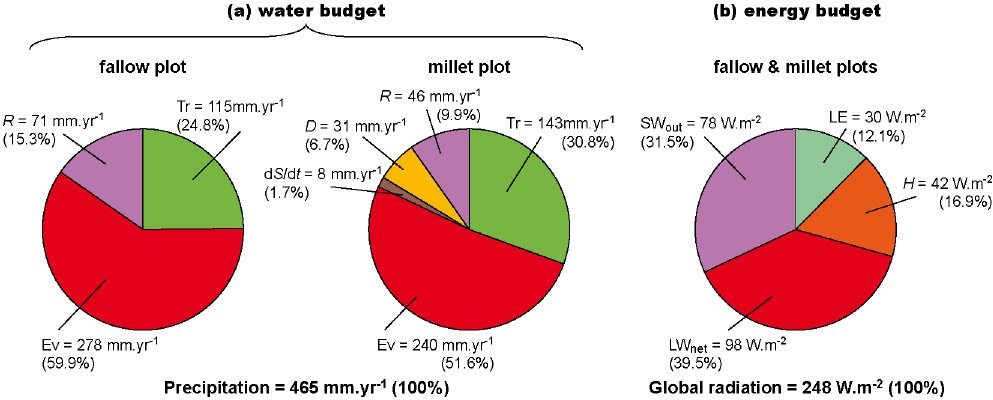
Figure 4. Estimated mean annual (a) water and (b) energy budgets for fallow and millet plots (average of two plots for energy budget, given their similarity at that aggregation scale). Please see Eq. (1) for abbreviations and Fig. 5 for standard estimation